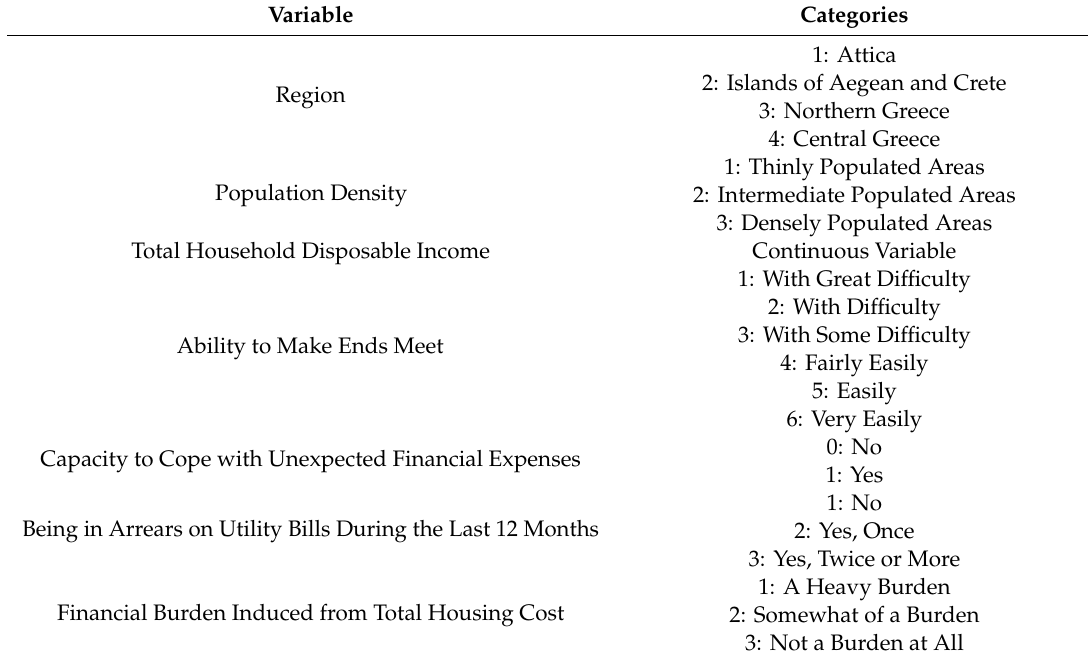
Table 1. Potential predictors (1st